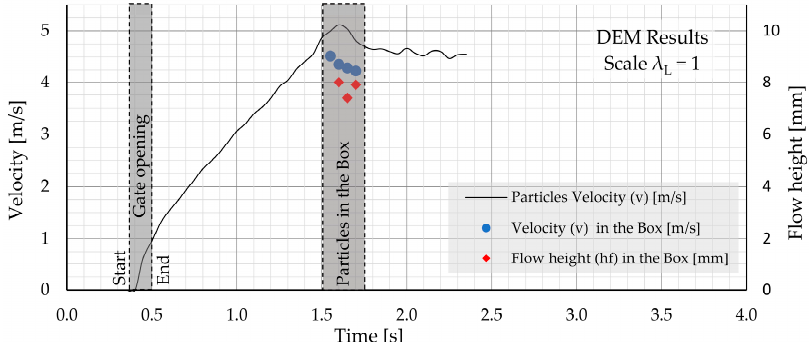
Figure 10. DEM results of velocity ( v ) and flow height ( h f ) (see text for definitions).